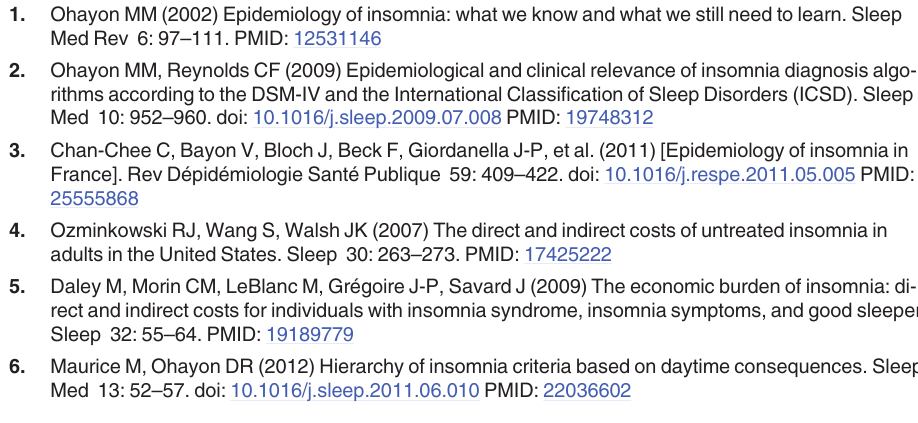
S1 Table. Relative power spectra for the delta band during stage 2. S2 Table. Relative power spectra for the beta band during stage 2. S3 Table. Relative power spectra for the delta band during stage 3+4. S4 Table. Relative power spectra for the alpha band during stage 3+4. S5 Table. Relative power spectra for the sigma band during stage 3+4. S6 Table. Relative power spectra for the beta band during stage 3+4. S7 Table. Relative power spectra for the beta1 band during stage